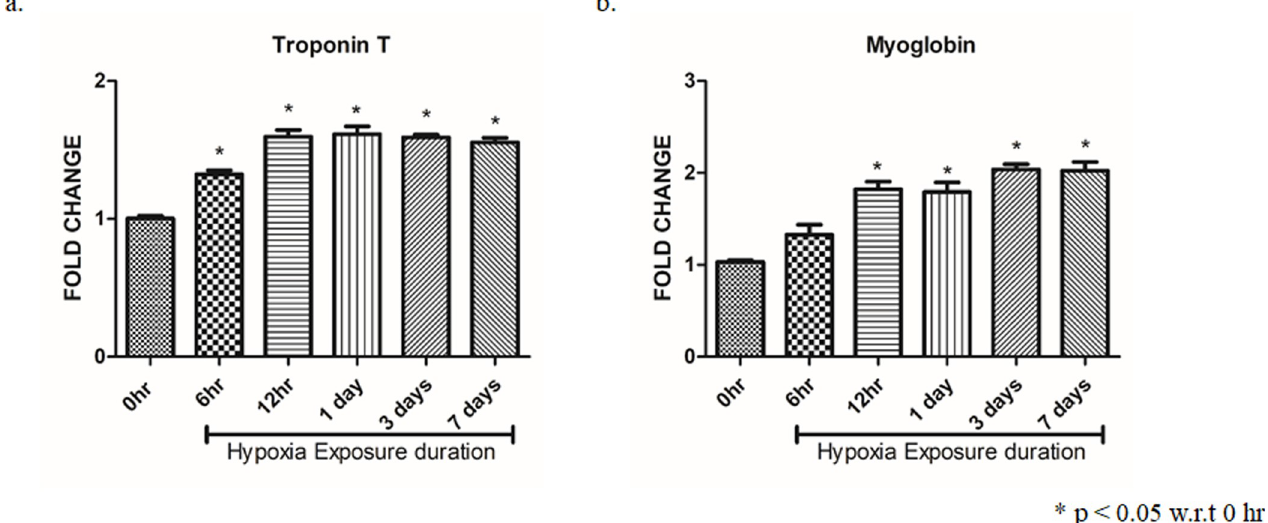
Fig 2. AH exposure induces myocardial injury in time dependant manner. Expression of cardiac injury markers in plasma samples after exposure of animals to hypoxia for different time durations (0–24 hrs, 3-7days); (a) cTrop-T, (b) Myoglobin.Data are shown as mean ± SEM (n = 5/group/treatment) from one experiment representative of three independent experiments, all performed in triplicate. One-way ANOVA revealed statistical significance in the results ( � p < 0.05).